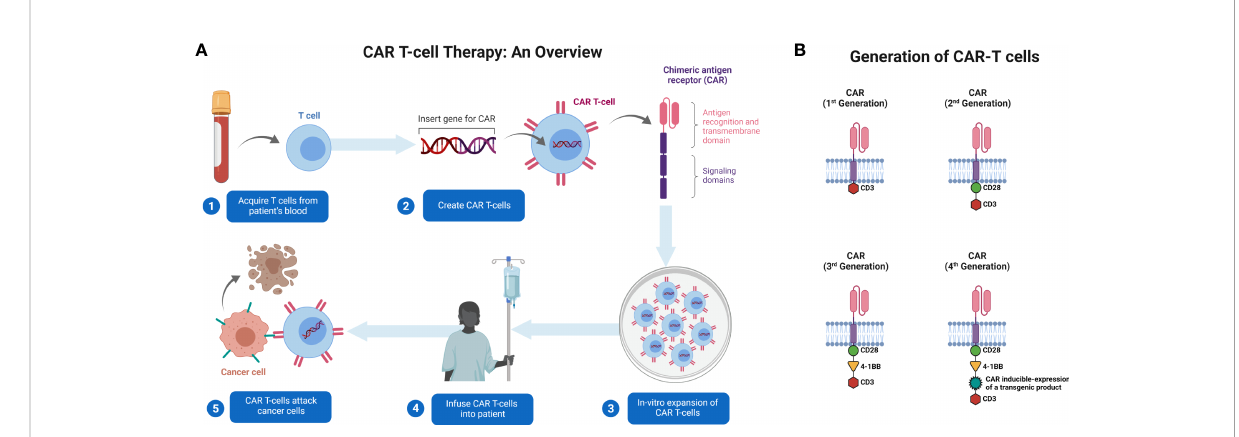
FIGURE 1 Generation and administration of CAR T-cells in patients with cancer. (A) T cells are collected from patients ’ blood via apheresis. They are genetically engineered to express CAR and cultured ex vivo for expansion. CAR T-cells are then administered to patients. The cells identify their target and kill the tumor cells expressing that target. (B) Illustration of basic structure of four generations of CAR T-cells. Created with